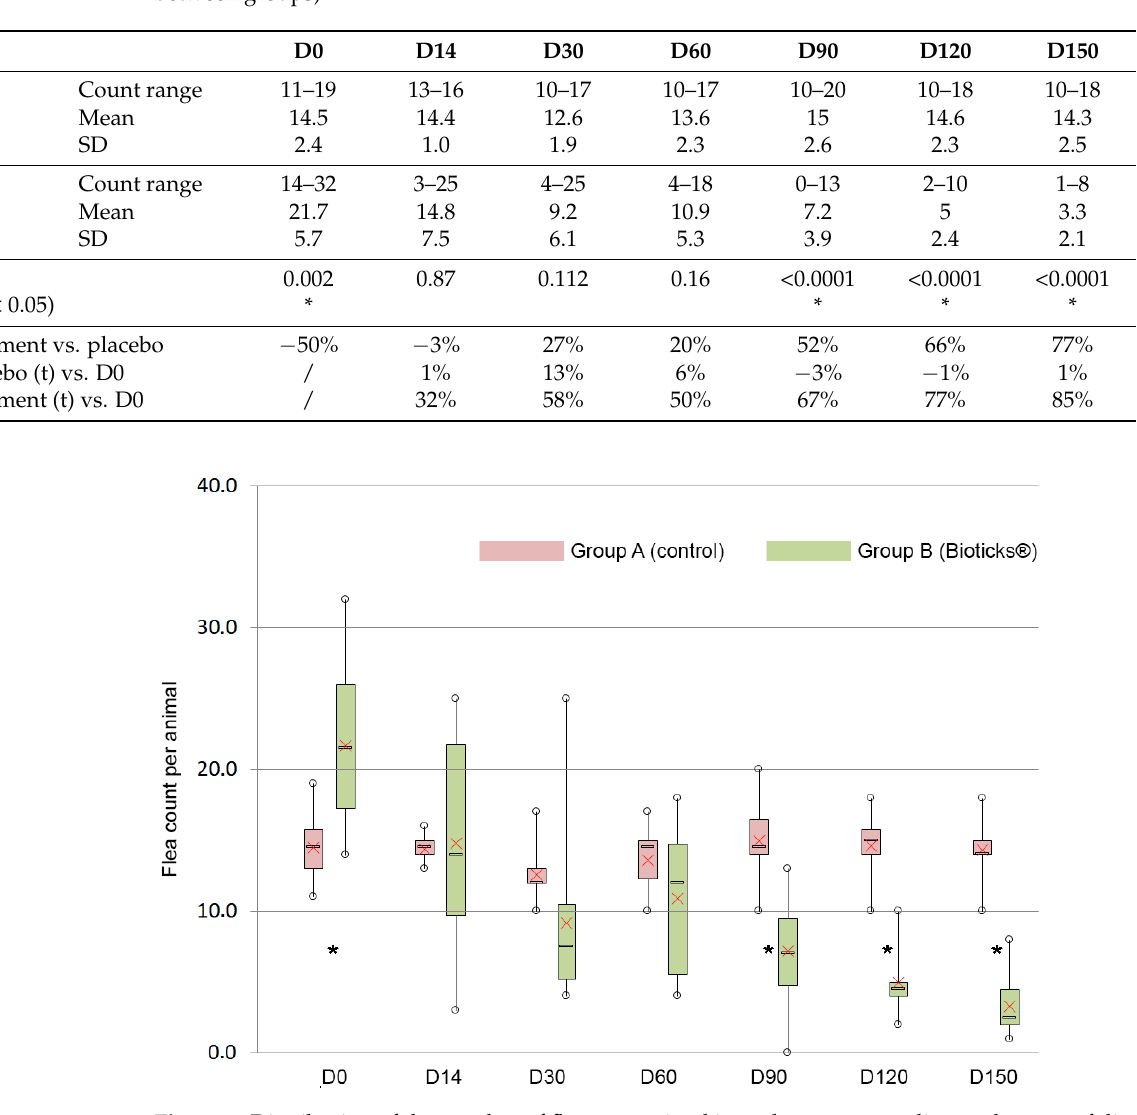
Figure 1. Distribution of the number of fleas per animal in each group according to the type of diet (red box = neutral, green box = supplemented) and to the time after the beginning of this study. In each box, the horizontal line represents the median value, the borders represent the 25th and 75th percentiles, and the whiskers show the range of all values. The red cross corresponds to the mean value. Stars * indicate a significant difference between groups ( p ≤ 0.05).